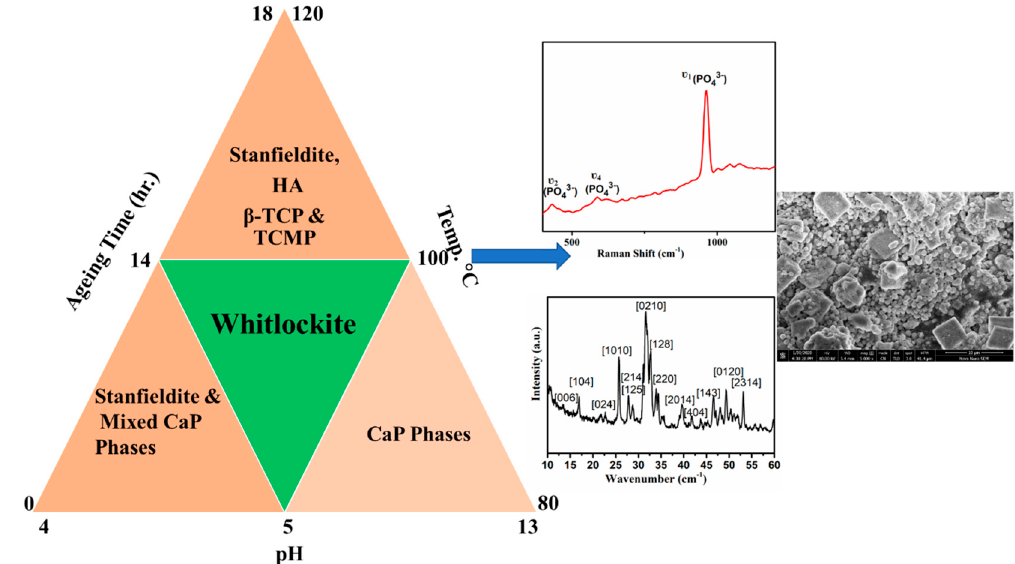
Figure 1. Schematics of approach used for WH synthesis.